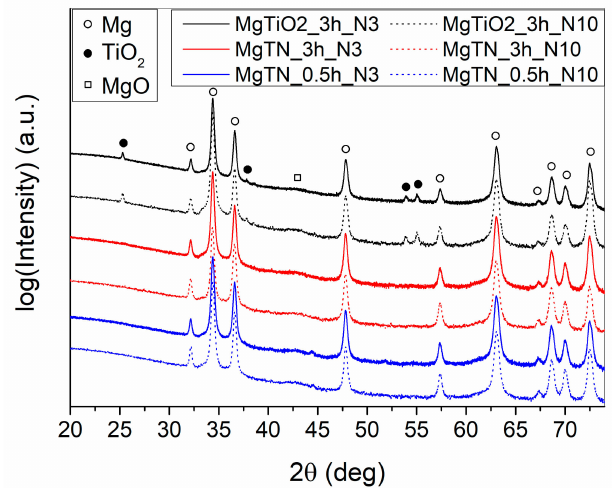
Figure 3. X-ray di ff raction (XRD) patterns of the high-pressure torsion (HPT) processed Mg composites after N = 3 and N = 10 revolutions.